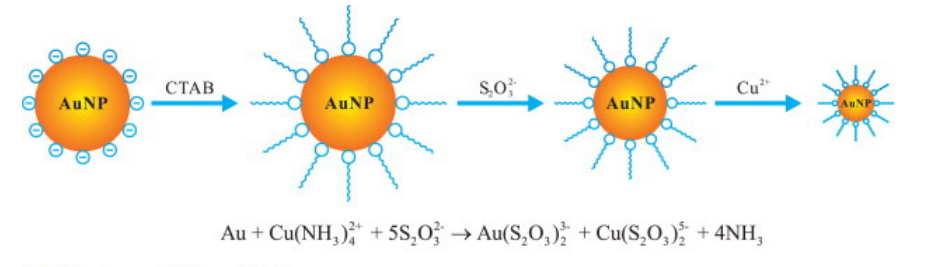
Figure 8. Scheme of the Cu(II) sensing based on the catalytic etching of AuNPs. Reprinted with permission from [112], copyright 2013 Elsevier B.V.